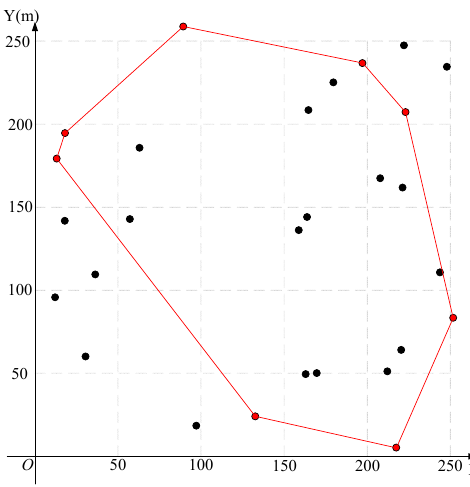
Figure 8. Feasible region for the 20 -node network.